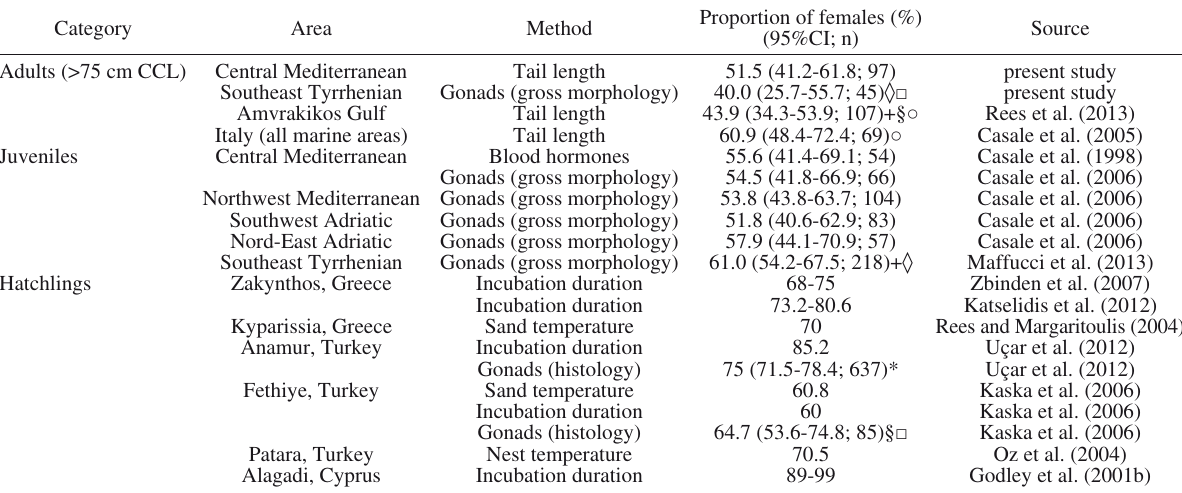
Table 1. – Known sex ratios of different life stages (hatchlings, juveniles and adults) of loggerhead sea turtles in the Mediterranean. Hatchling sex ratios are from nesting beaches while juvenile and adult sex ratios are from foraging areas. Sex ratios where real numbers of males and females are available (i.e. where n is shown) were compared (Fisher exact test), and those significantly different are indicated as follows: * this sex ratio resulted different (p<0.01) in all the pairwise tests with the other values; five pairs of sex ratio values which differed with p<0.05 are indicated by five pairs of the symbols ◊ , □ , +, §, ○